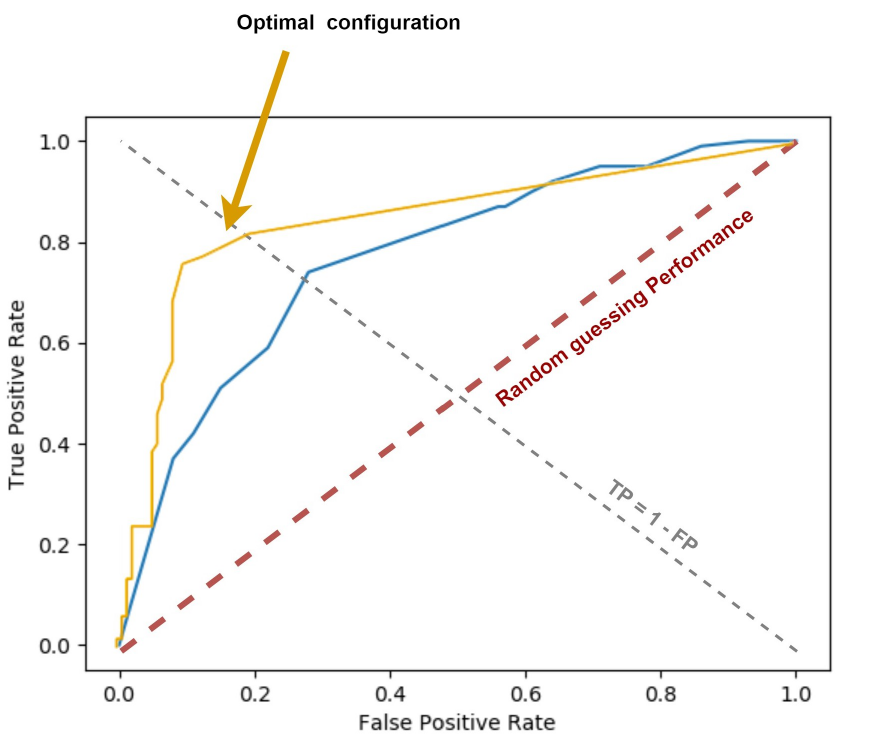
Figure 15. Click detector ROC (receiver operating characteristic) curve using the state machine and expert rules validation (in yellow), versus without it (in blue) for different values of K 1 parameter. Area under the ROC curve is 85% using the state machine and expert rules, versus 75%